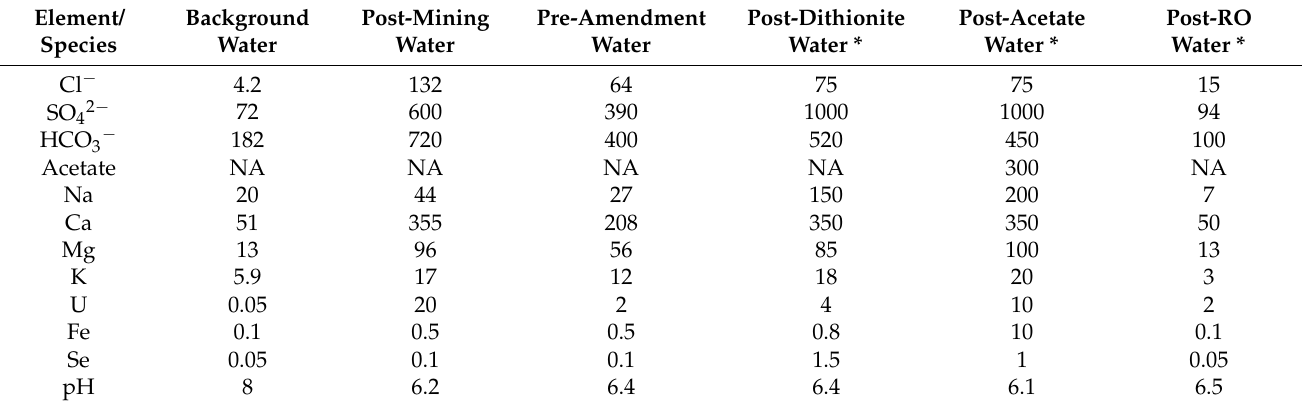
Table A12. Water chemistries assumed for the PHREEQC calculations of Tables 2 and